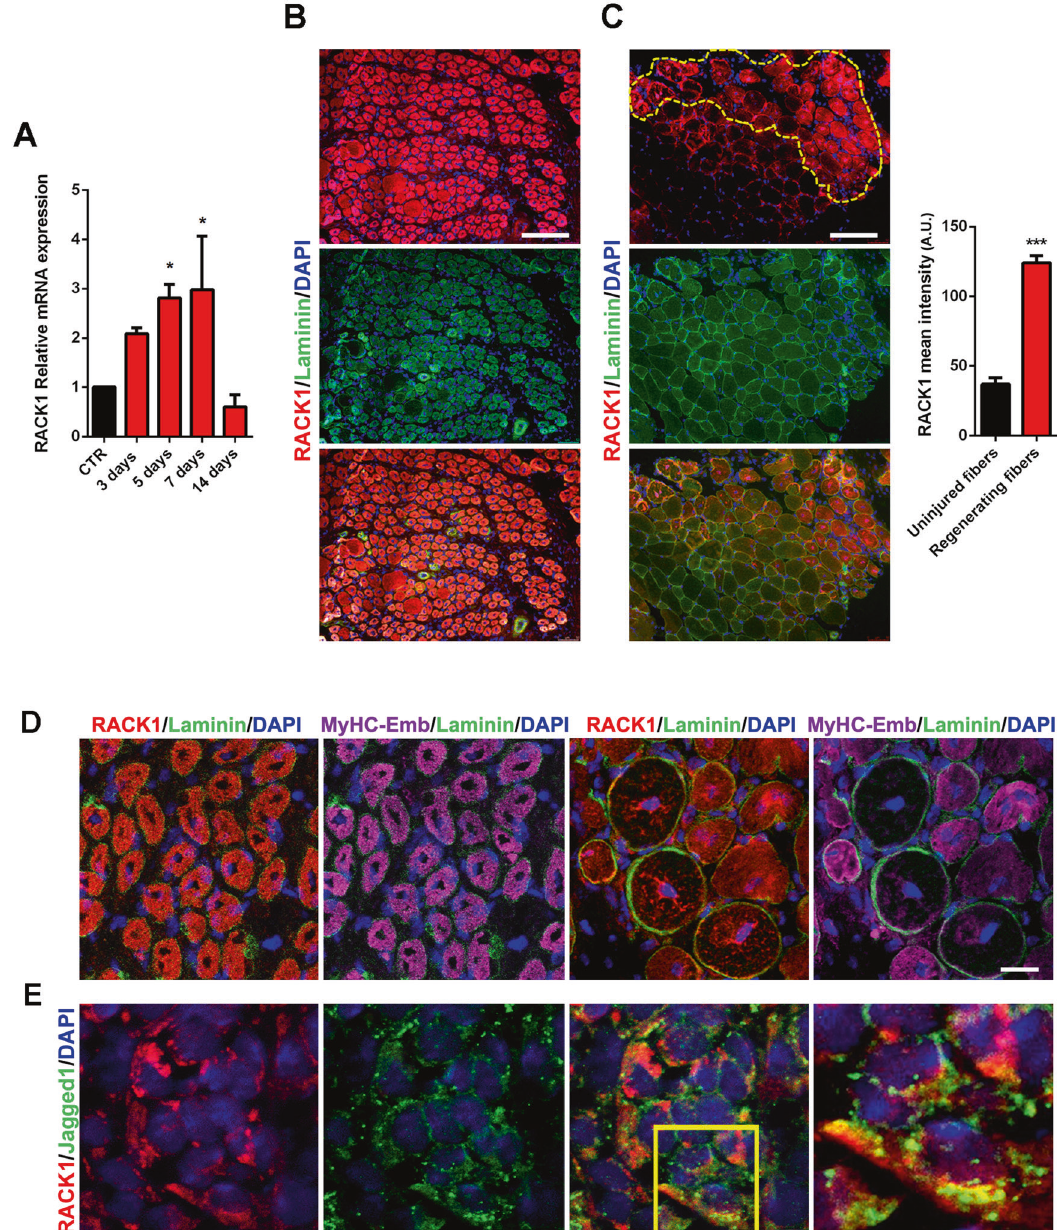
Fig. 3 RACK1 expression in response to mouse muscle acute damage. A mRNA levels of RACK1 by RT-qPCR in TA muscle of CTX-injected mice at 3, 5, 7, and 14 days. Results are expressed as fold change of control (CTR, not injected) muscle (dashed line). Data are representative of 4 mice. * P < 0.05 vs CTR. B , C Confocal fl uorescence imaging of RACK1 (red), Laminin (green), and DAPI (blue) in transversal TA muscle sections after 7 days post CTX injection (scale bars: 50 µm). The dashed yellow line represents the regenerating area. Right panel: mean RACK1 intensity signals in regenerating compared to uninjured fi bers (A.U.: arbitrary units). *** P < 0.001 vs uninjured. D Confocal fl uorescence imaging of RACK1 (red), Laminin (green), MyHC-Emb (purple), and DAPI (blue) in transversal TA muscle sections after 7 days post CTX injection (scale bar: 20 µm). E Confocal fl uorescence imaging of RACK1 (red), Jagged1 (green), and DAPI (blue) of interstitial activated SC in transversal TA muscle sections at 7 days after CTX injection (scale bar: 5 µm). Insert represents enlarged image details of RACK1 + /Jagged1 + cells showed in the right panel. Images and quantitative data are representative of 6